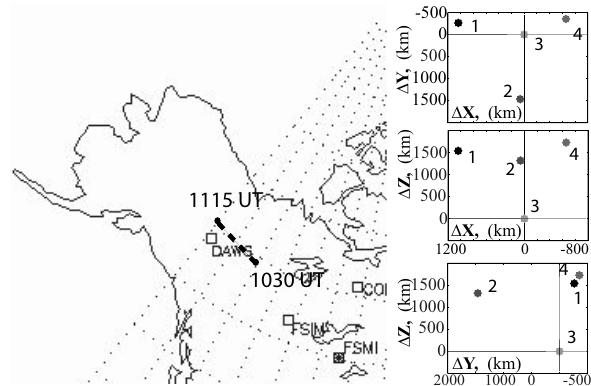
Fig. 1. Geometric projection of the Cluster orbit, calculated us- ing T96 model, and the Cluster tetrahedron configuration at 10:20– 11:15 UT, 29 August 2001 (day 241).